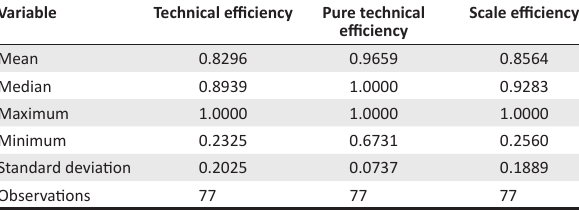
TABLE 1: Descriptive statistics of data envelopment analysis measures.